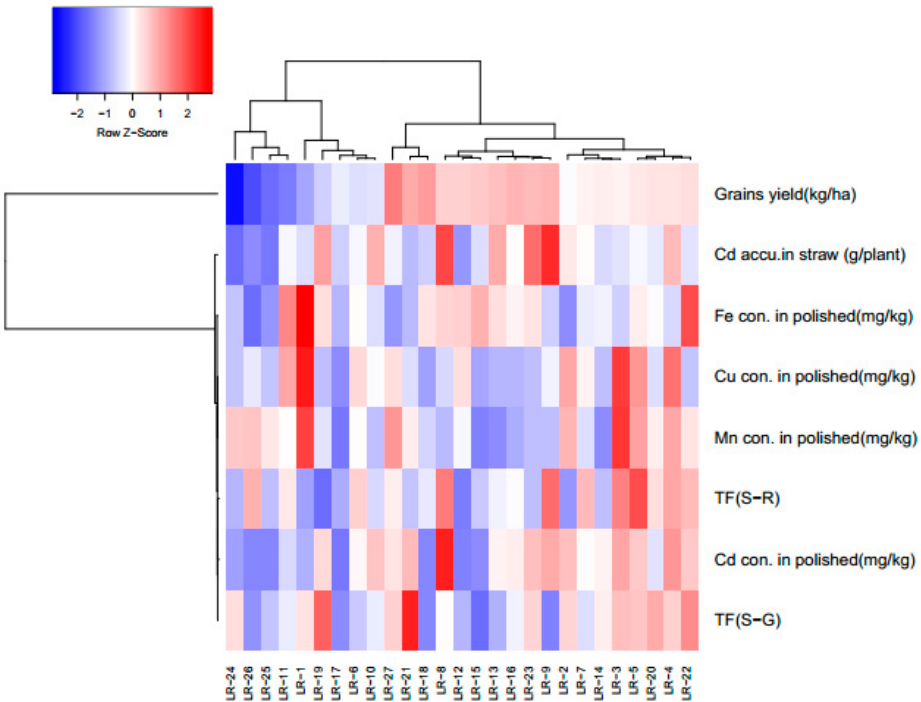
Figure 7. Criteria for the selection of safe production of late rice cultivars.